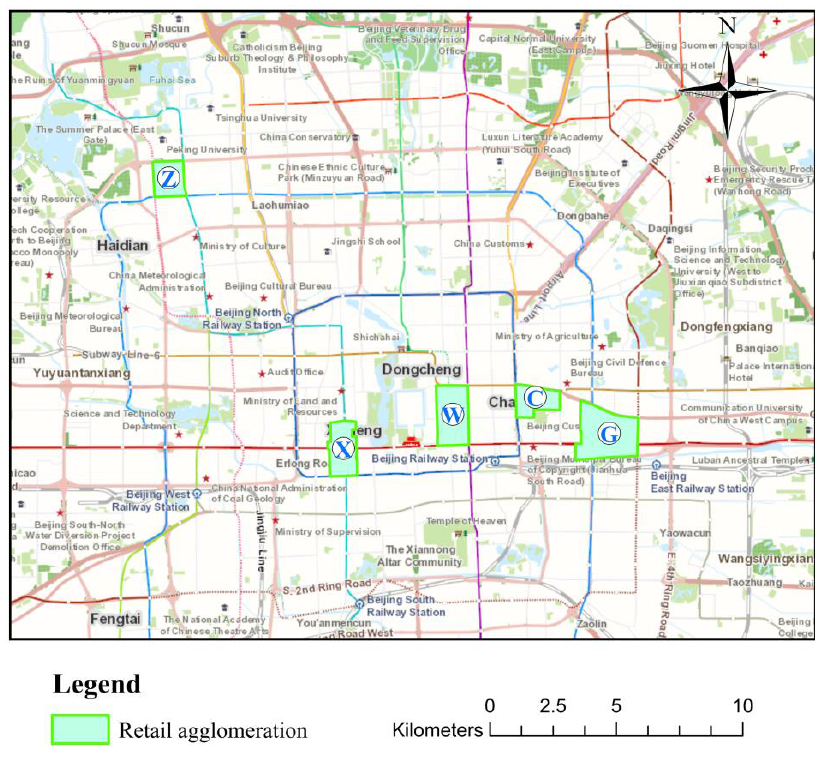
Figure 1. The distribution of each retail agglomeration.